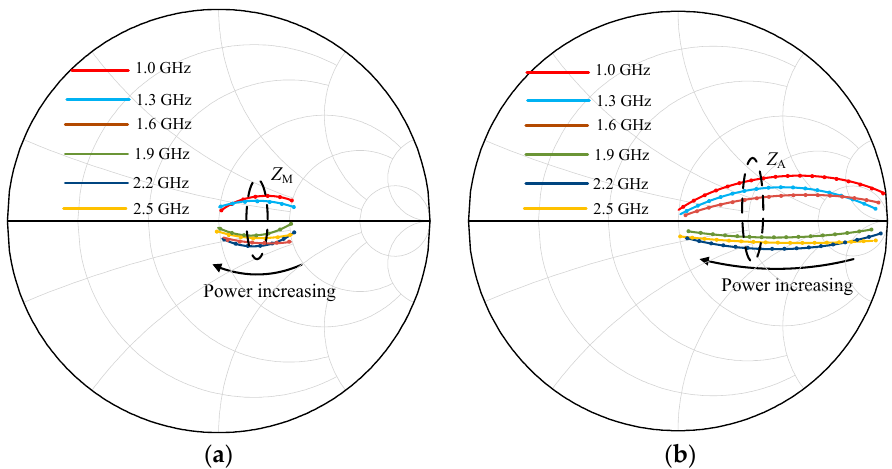
Figure 15. Trajectories of impedance Z M and Z A at several representative frequencies: ( a ) impedance Z M ; ( b ) impedance Z A .